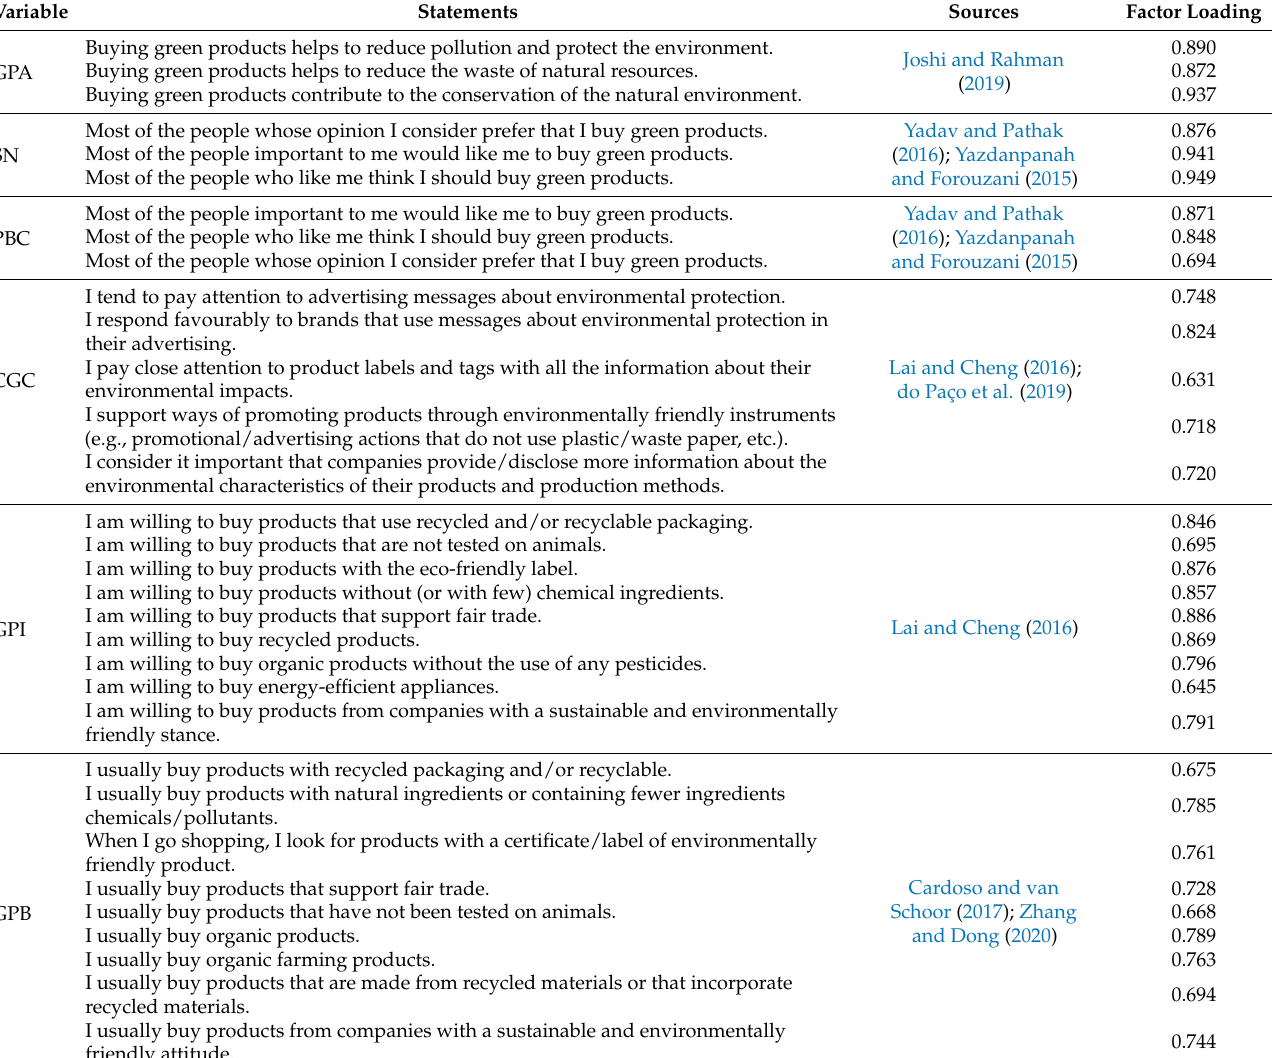
Table 1. Variables and their measuring statements included in the questionnaire.